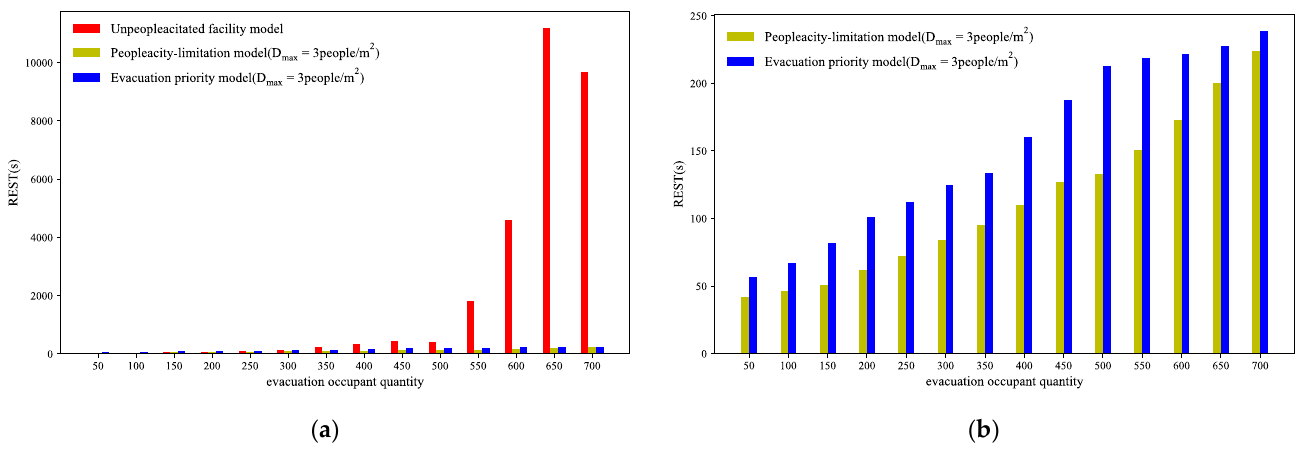
Figure 16. RSET comparison of evacuation simulations with different evacuation models. ( a ) RSET for evacuation simulation of three types of models; ( b ) Comparison of RSET between path capacity constraints and adding evacuees’ priority based on the path capacity constraints.